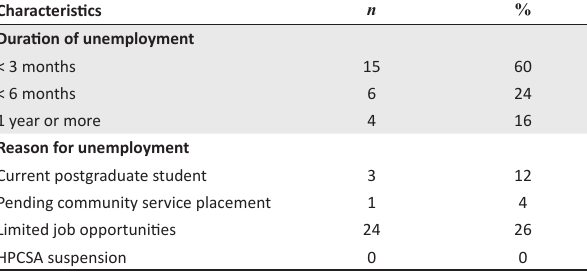
TABLE 3: Unemployed participants in the second-year postgraduation ( n = 25). Characteristics